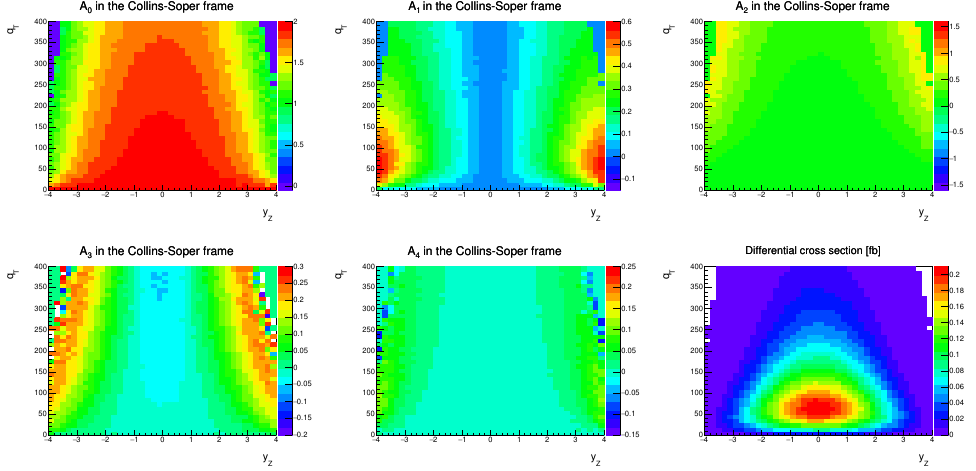
Figure 11 . Angular coe(cid:14)cients A 0 scenario S1 c